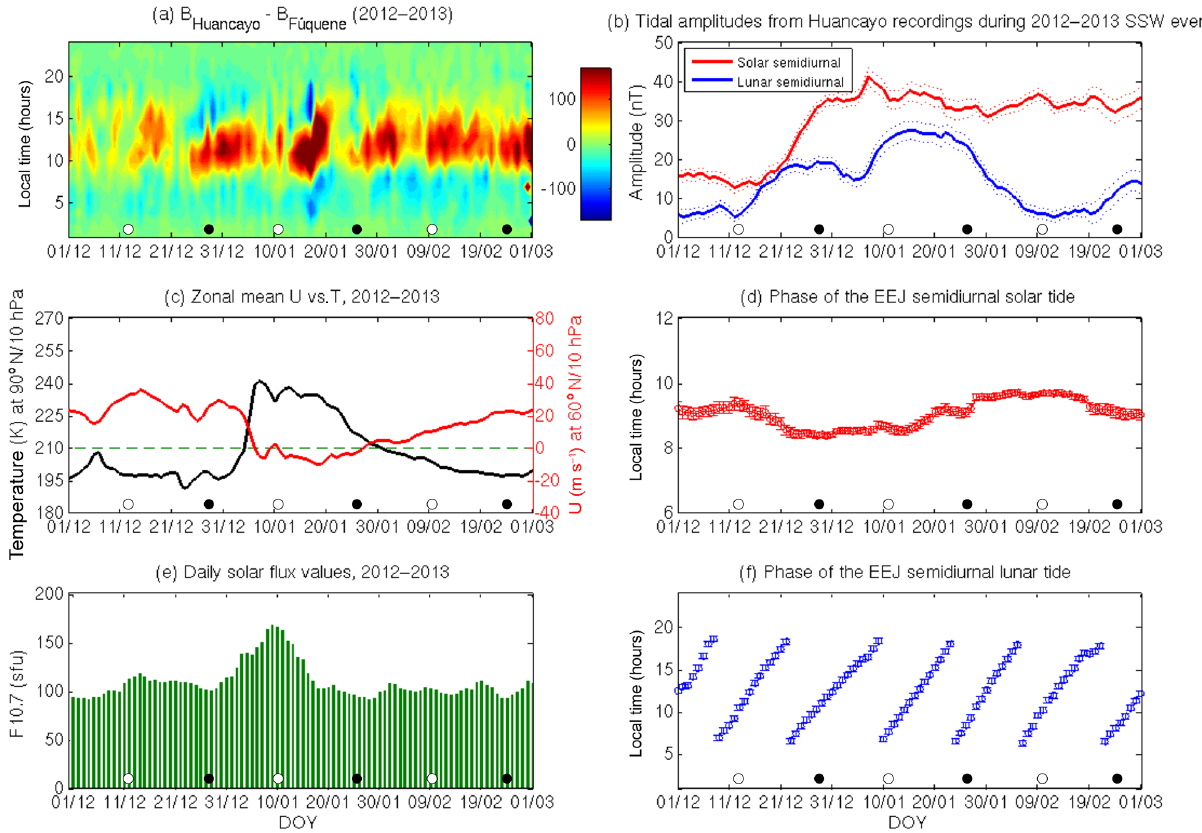
Figure 5. Same as Fig. 2, except between 1 December 2012 and 1 March